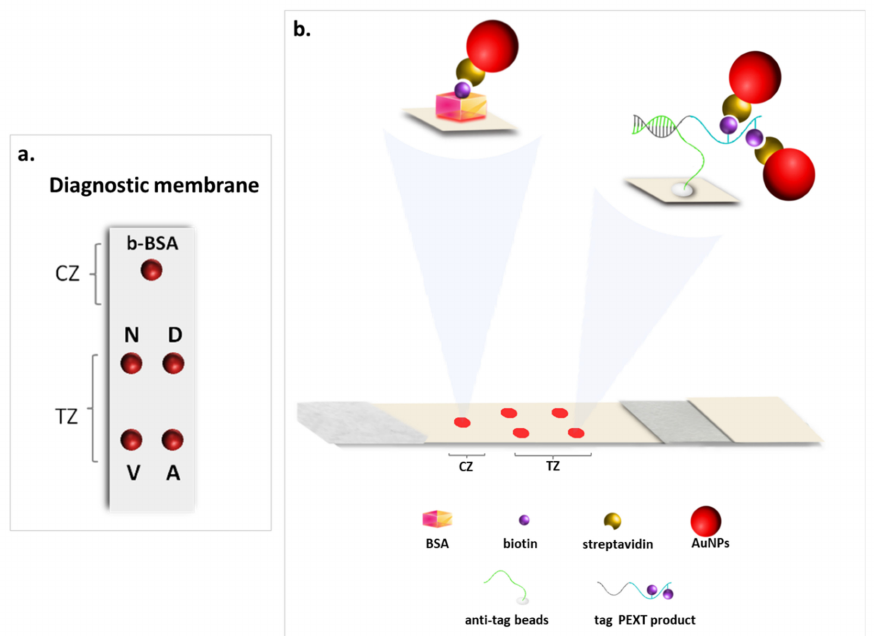
Figure 1. ( a ) Layout of the test and the control spots on the diagnostic membrane of the multiplex strip test. ( b ) The principle of the multiplex strip test. b-BSA: biotinylated BSA, N: normal allele, D: G12D mutant allele, V: G12V mutant allele, A: G12A mutant allele, TZ: test zone, CZ: control zone, AuNPs: gold